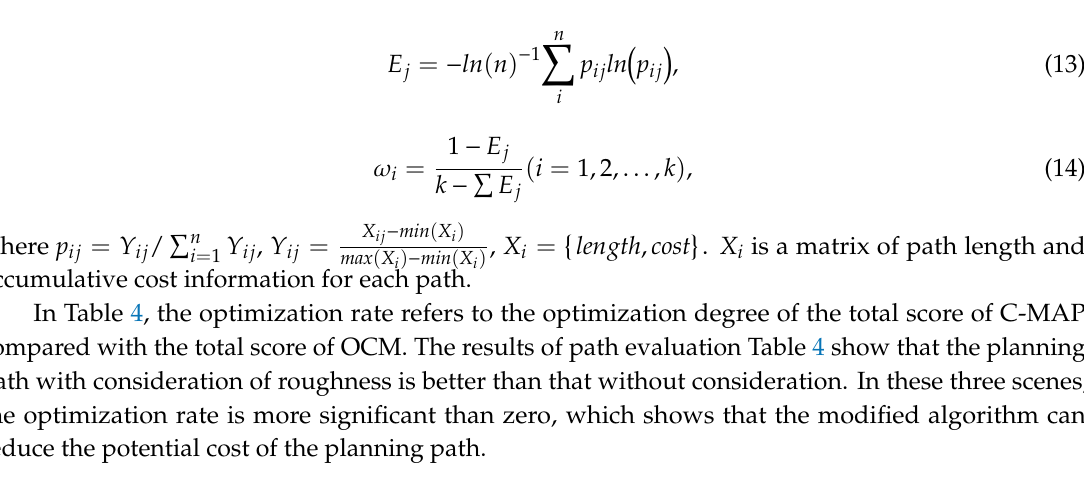
Table 4. Planning Path Evaluation Table in Two